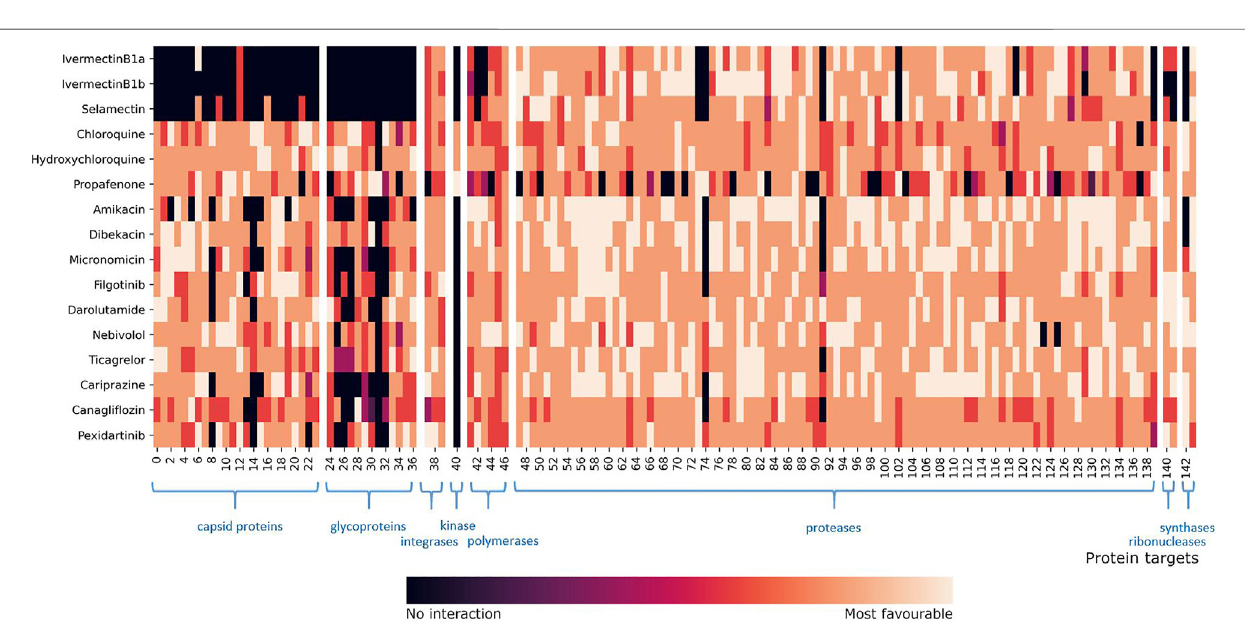
FIGURE 6 | Heatmap representation of compound fi ngerprints for the complete viral target database (11,640 proteins) of all hit compounds. The total number of combinedtargetsis144,andthelistofPDBIDsisfoundin SupplementaryTableS20 .Thevaluesshownintheheatmapwerecalculatedandcoloredaccordingtothe normalizeddockingscoreforeachcompound.Interval0meansthatthecompounddidnotinteractwiththetarget,whileinterval5meansthatthecompoundhadamost favorable docking score. Protein targets are grouped according to their class and classes emphasized in blue color.